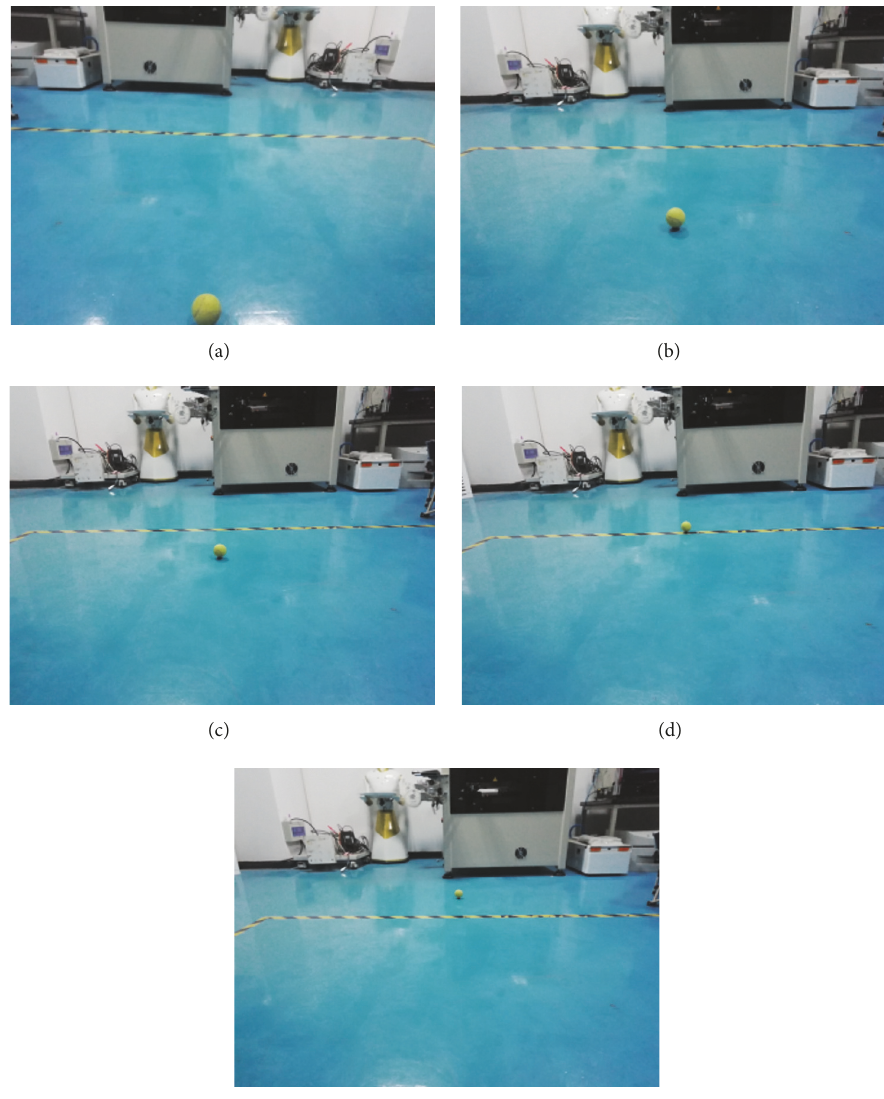
Figure 12: (a)-(e) Different position point of the target from near to